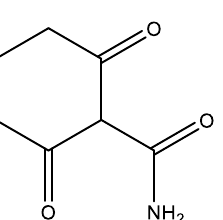
Figure 16. Tetracycline.